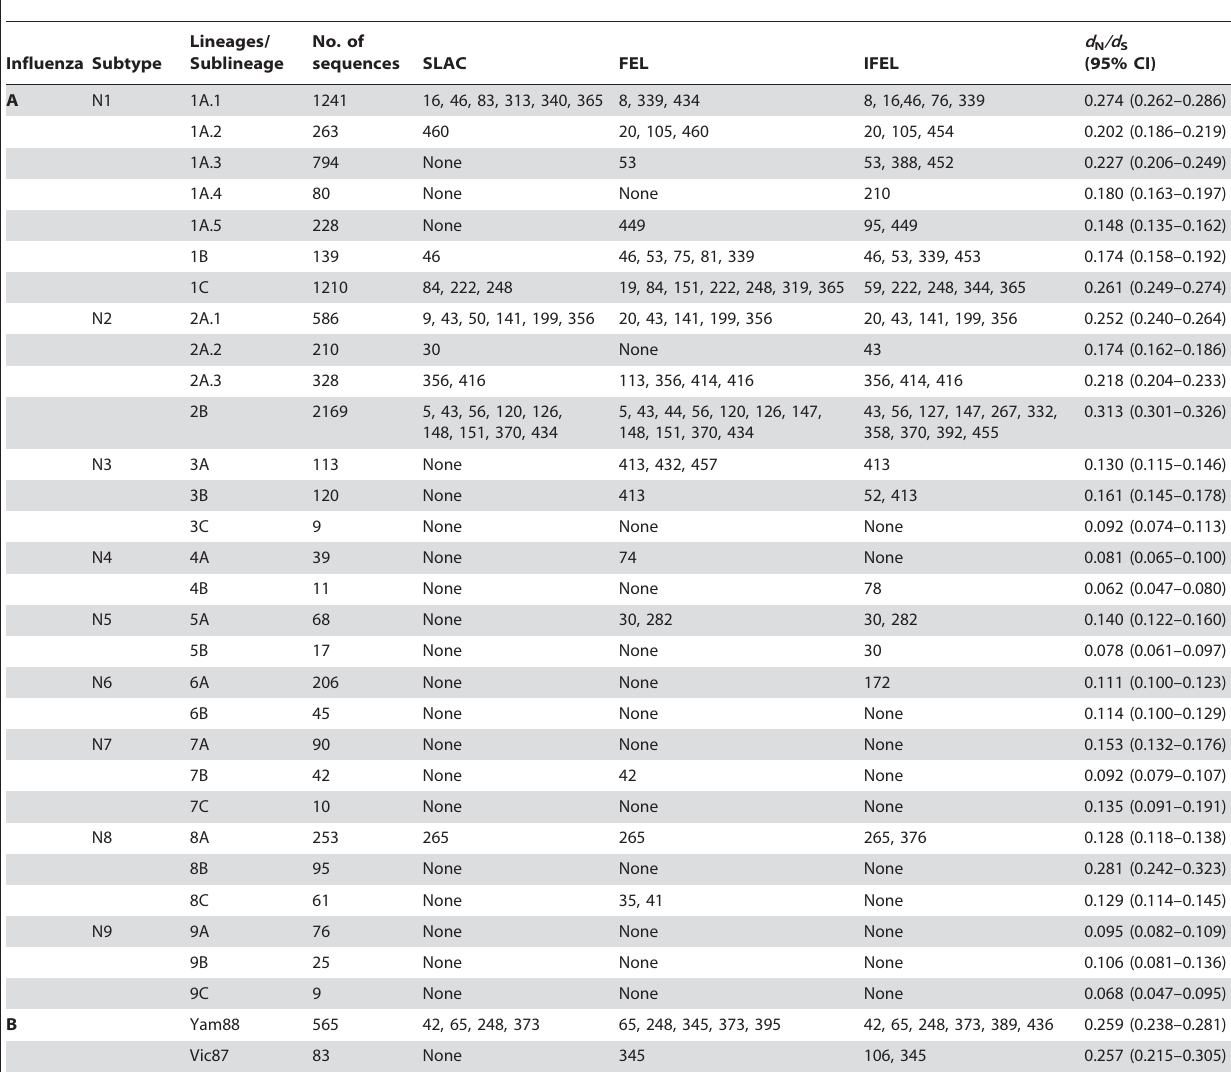
Table 3. Evidence of positive selection using the SLAC, FEL and IFEL methods with a significance level of 0.05.